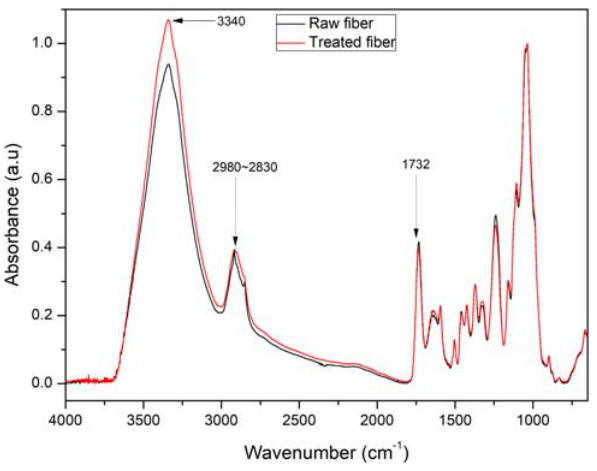
Figure 2: FTIR spectra of raw and pretreated fi